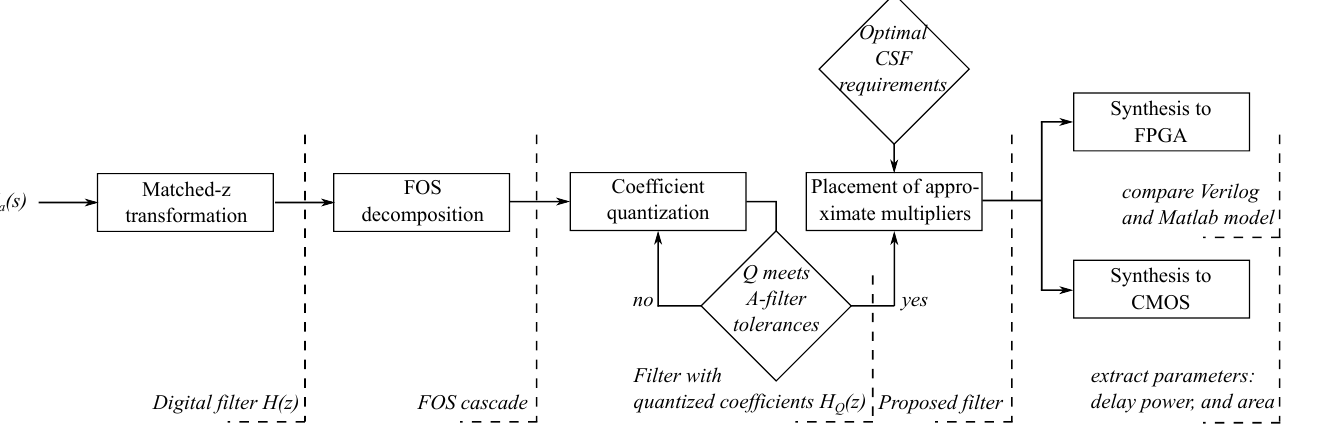
Figure 14. The proposed design